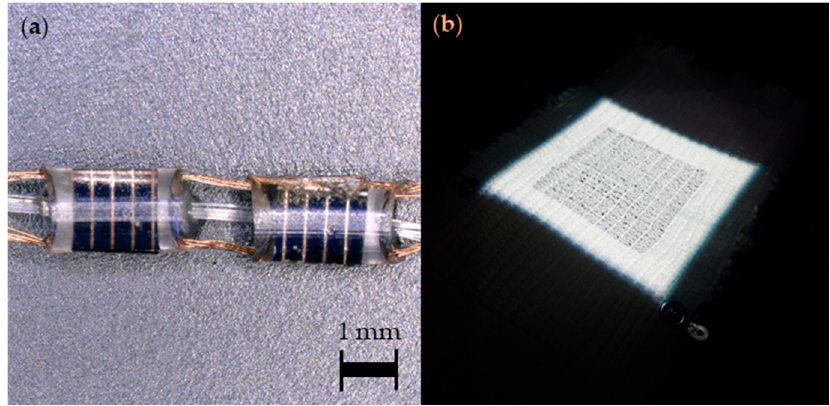
Figure 4. ( a ) Rigid solar cells soldered onto flexible copper wires. The filaments would subsquently be covered with textile fibers. ( b ) A woven solar fabric.